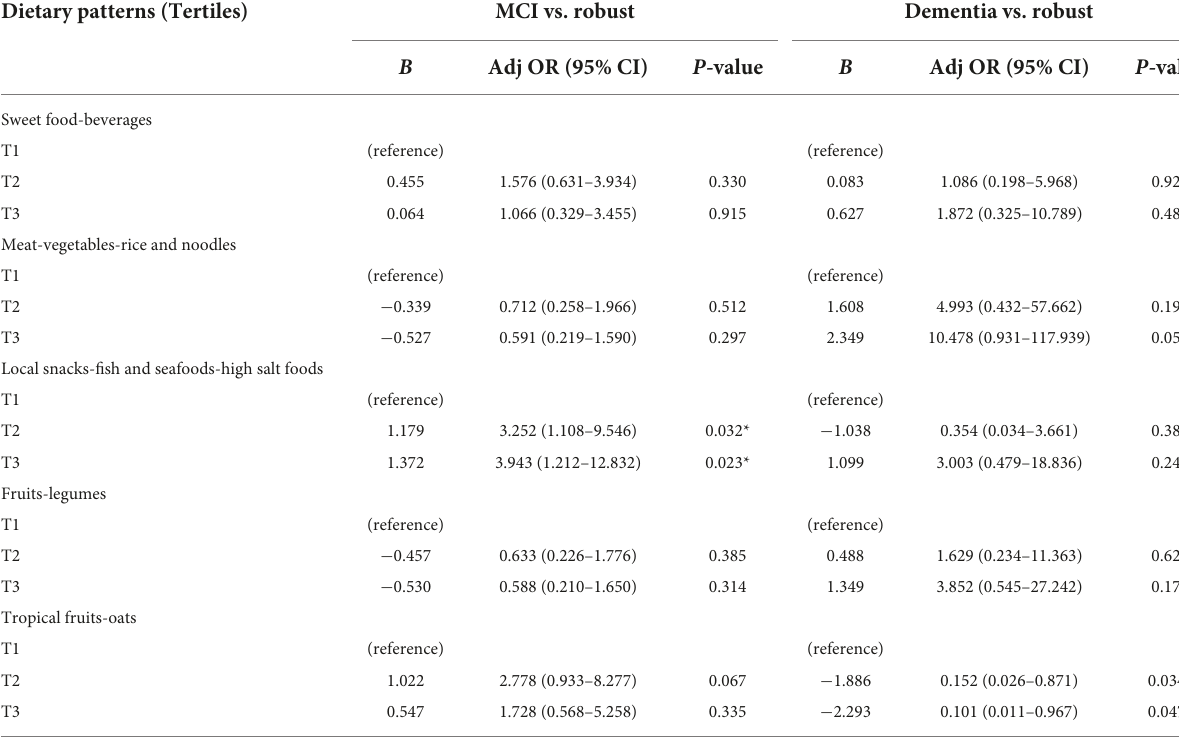
TABLE 3 Adjusted odd ratios for MCI and dementia according to the tertiles of dietary pattern scores ( n = 280). Dietary patterns (Tertiles) MCI vs.